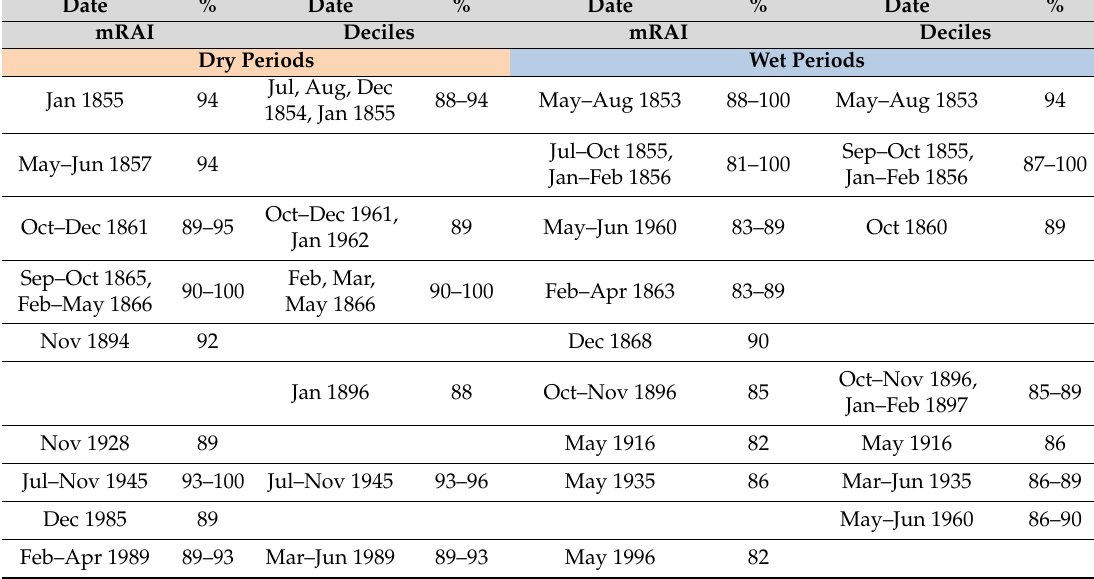
Table A7. Sub-region Mediterranean Region—overview on the TOP20 months with the highest spatial extent of dry and wet periods within the study period 1851–2015.